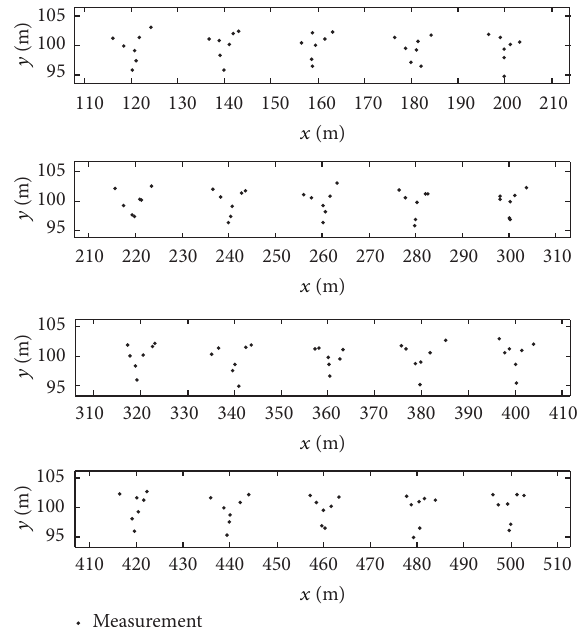
Figure 6: The real measurements of the extended target (1 ∼ 20 frames).